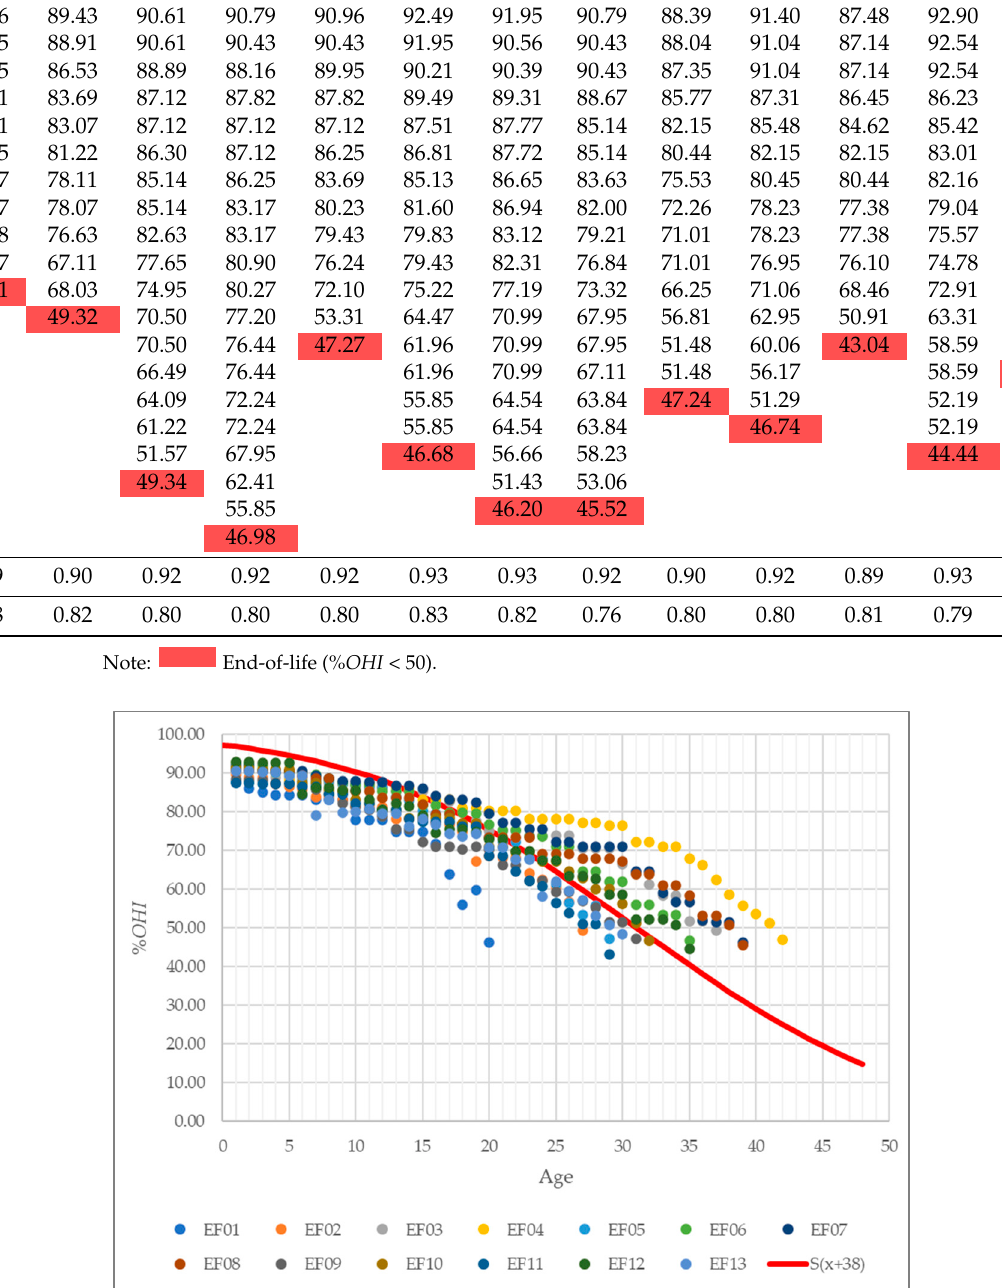
Figure 7. All the % OHI records of 13 retired underground cable systems. Table 6. Statistical % OHI records of 13 retired underground cable